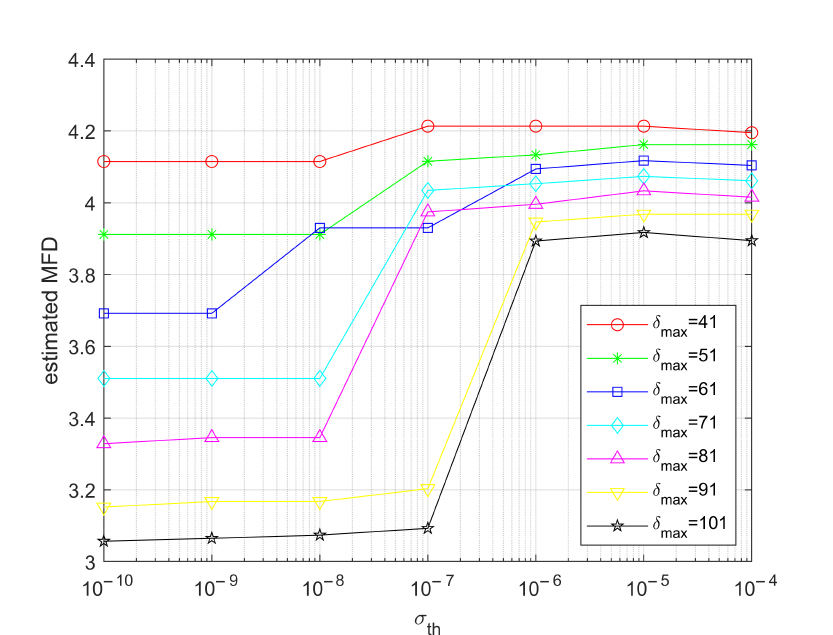
Figure 14. The estimated multi-spectral fractal dimension as a function of σ th for the medium generated complexity ( H = 0.5) multi-spectral fractal image.